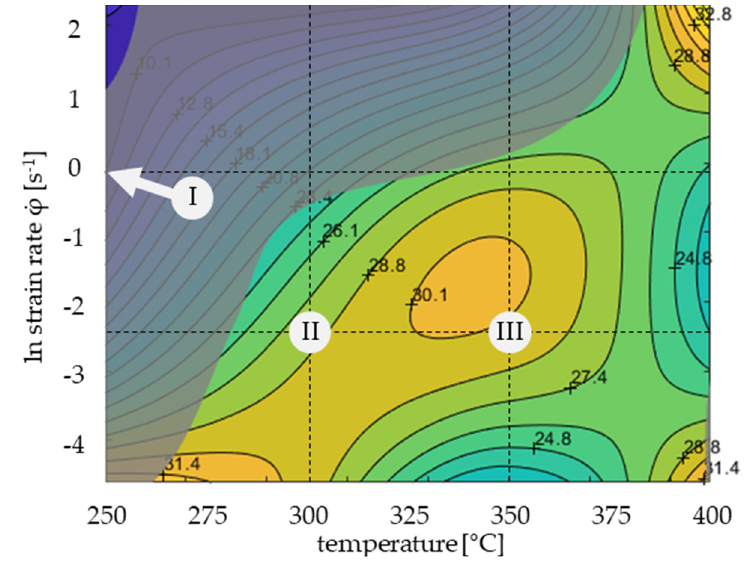
Figure 11. Processing map for twin-roll cast and annealed (460 °C/15 min) AZ31 at an equivalent logarithmic strain of 0.4.